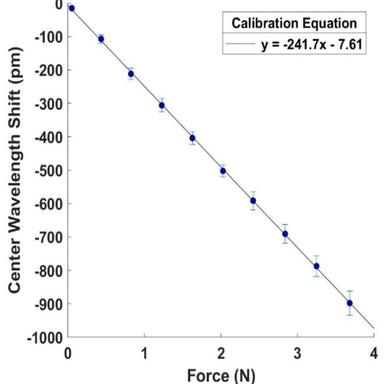
Sensor calibration results. The data was fitted with a first-order polynomial. The maximum non-linearity error based on the calibration equation was estimated to be 22 mN.